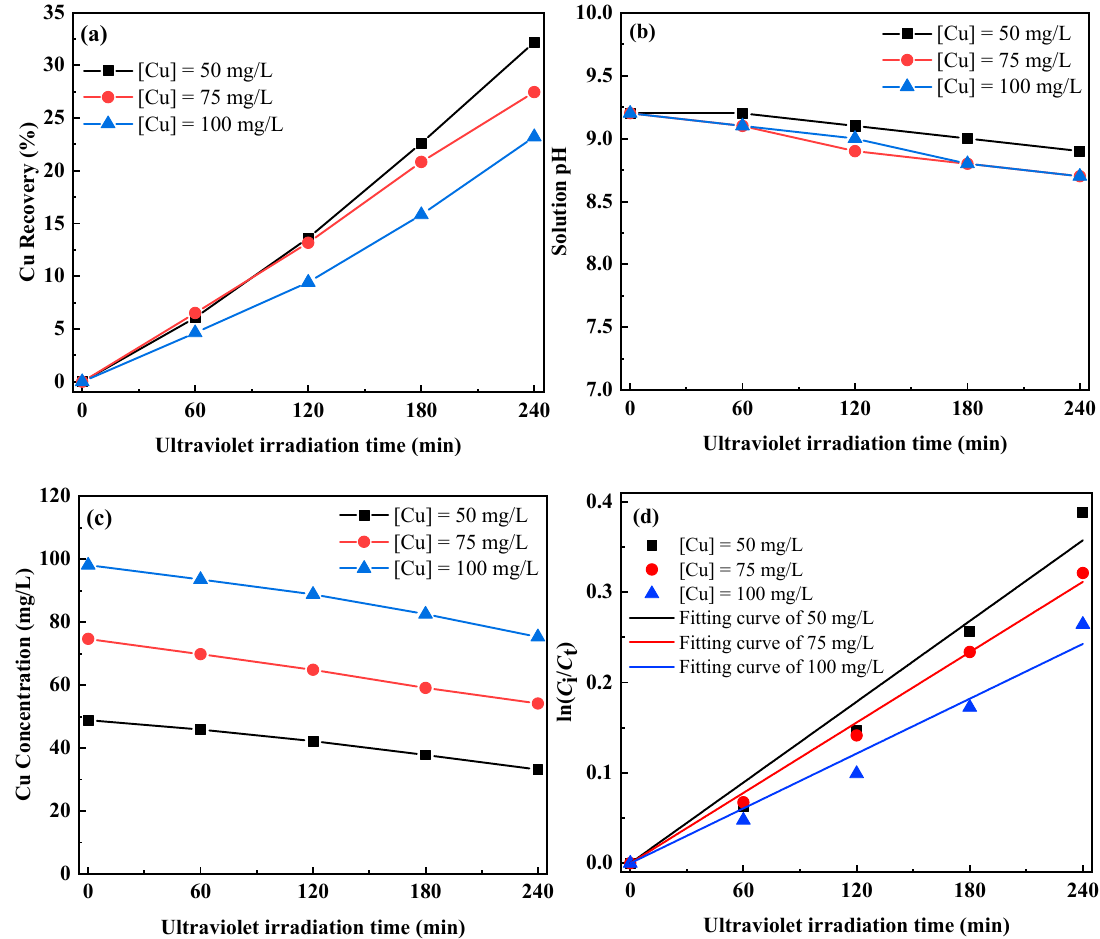
Figure 5. Effect of copper concentration on the photolysis of a silver–thiosulfate complex by UV-C ( a ) Cu recovery vs. time; ( b ) variation for solution pH; ( c ) Cu concentration vs. time; ( d ) plot of ln ( C i / C t ) vs. time; [S 2 O 32 − ] = 0.1 mol/L, 298 K, uncontrolled pH.